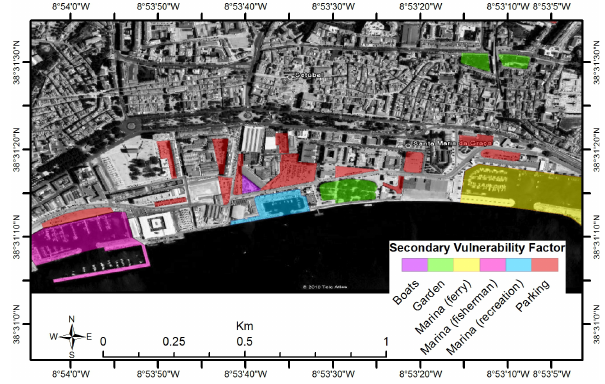
Fig. 7. Secondary vulnerability factors